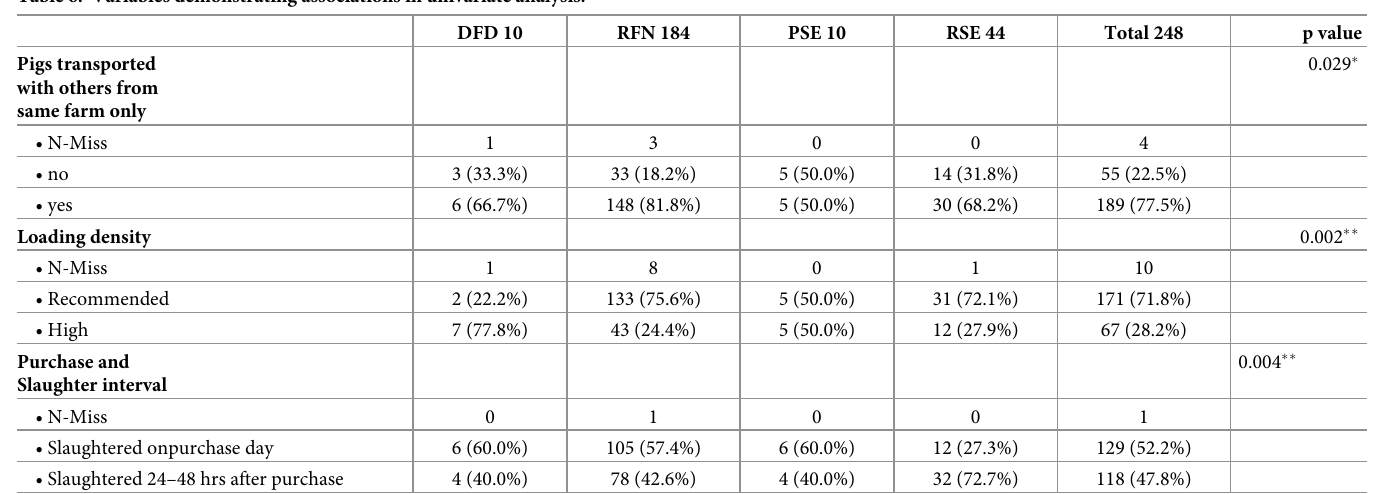
Table 6. Variables demonstrating associations in univariate analysis.